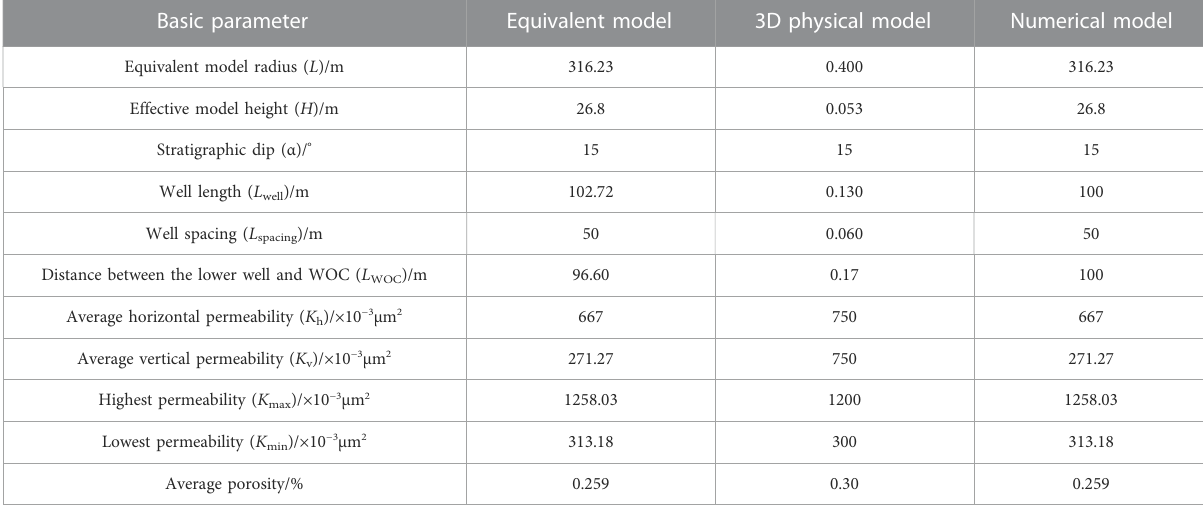
TABLE 1 Basic parameters for the equivalent reservoir, physical model, and numerical model.